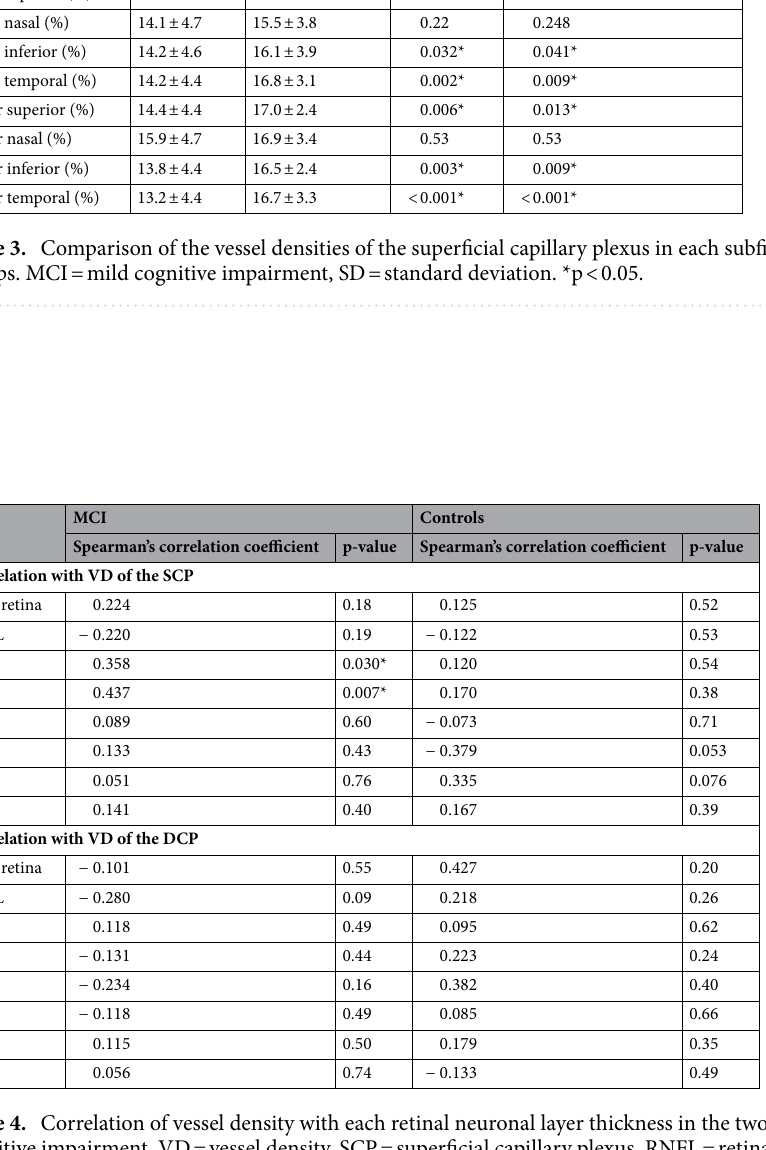
Table 4. Correlation of vessel density with each retinal neuronal layer thickness in the two groups. MCI = mild cognitive impairment, VD = vessel density, SCP = superficial capillary plexus, RNFL = retinal nerve fiber layer, GCL = ganglion cell layer, IPL = inner plexiform layer, INL = inner nuclear layer, OPL = outer plexiform layer, ONL = outer nuclear layer, RPE = retinal pigment epithelium, DCP = deep capillary plexus. *p < 0.05.